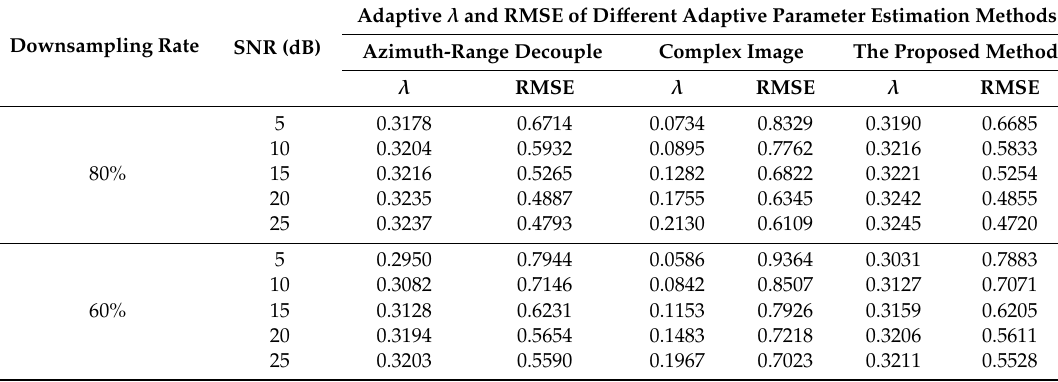
Table 3. The adaptive λ and RMSE for di ff erent SNR and downsampling rate.